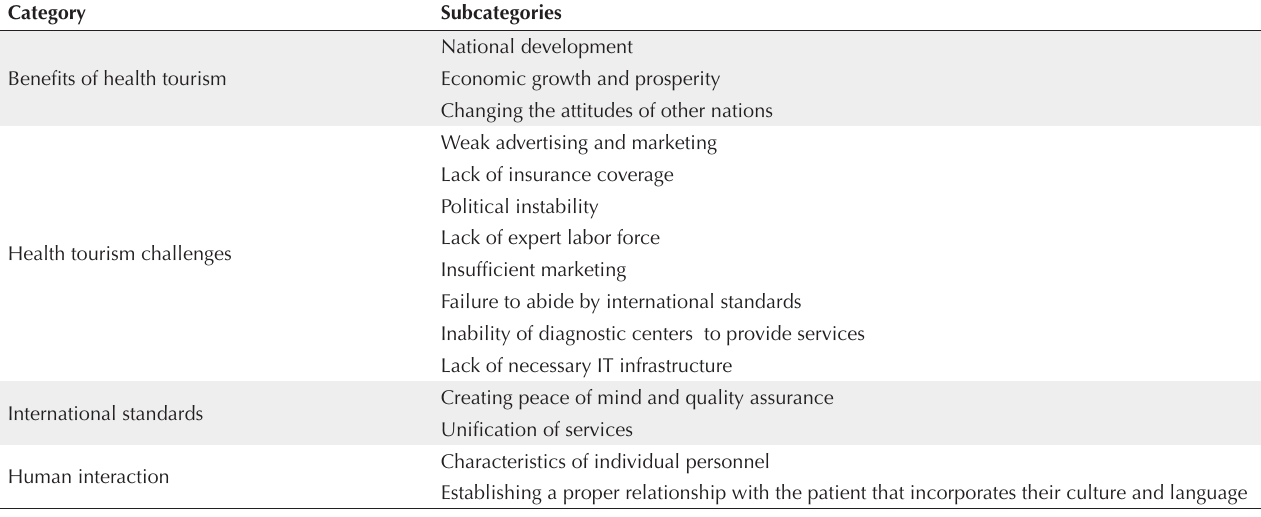
Table 1. Statements of Participants About the Use and Transfer Health Tourism Knowledge